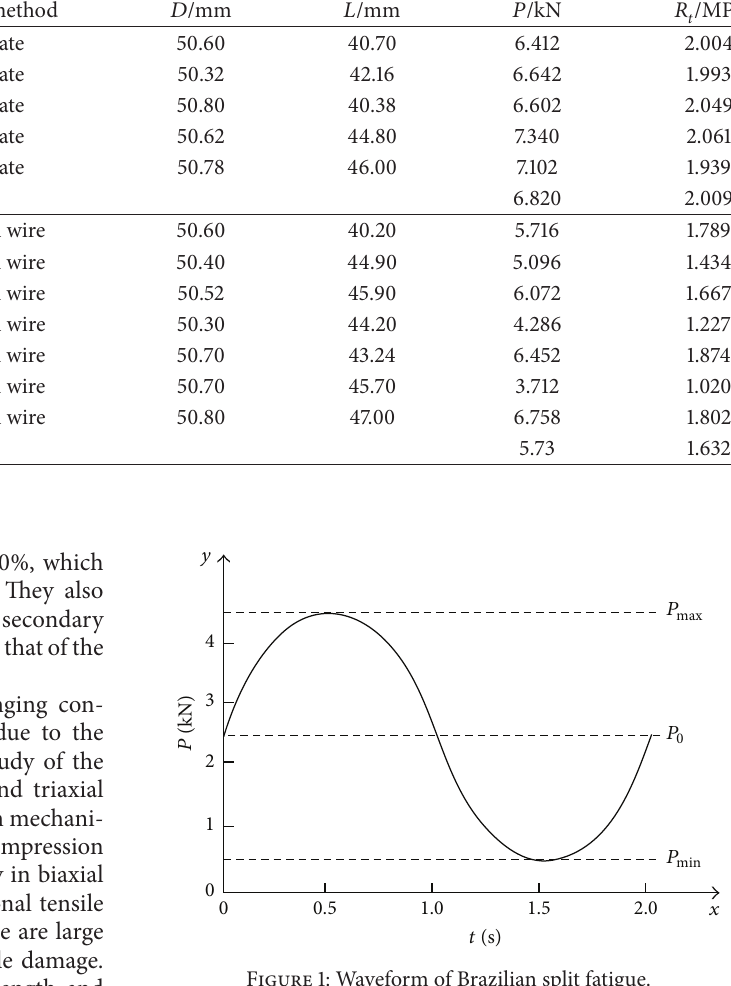
Figure 1: Waveform of Brazilian split